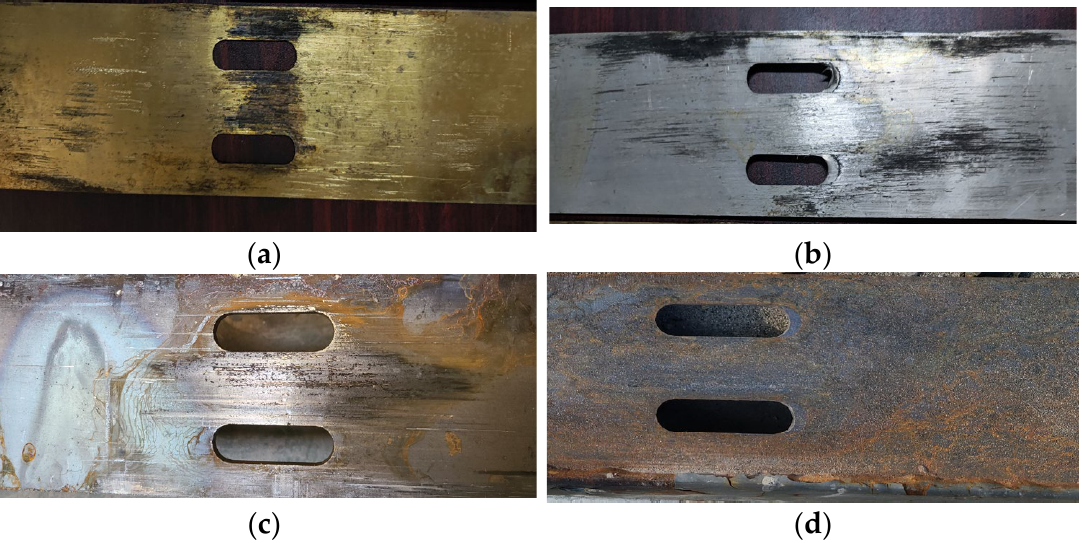
Figure 7. Scratches of different friction surfaces: ( a ) SJ1, brass; ( b ) SJ4, aluminum; ( c ) SJ5, no friction plates; ( d ) SJ6, shot blasting.